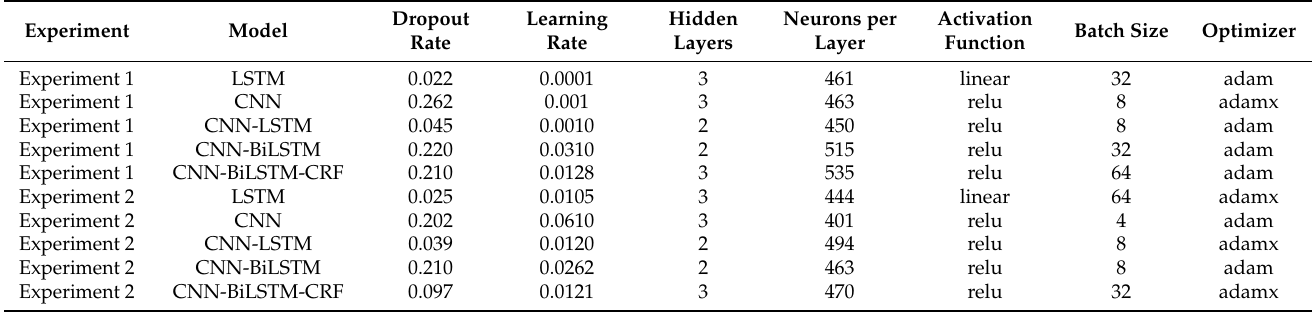
Table 2. The suggested network architecture based on the hyperparameter values obtained using Bayesian Optimization for both